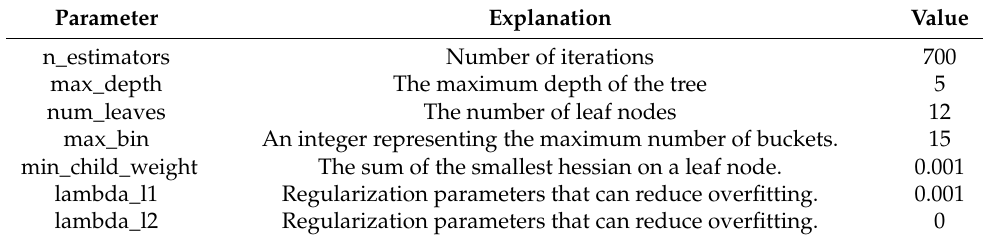
Table 3. LightGBM